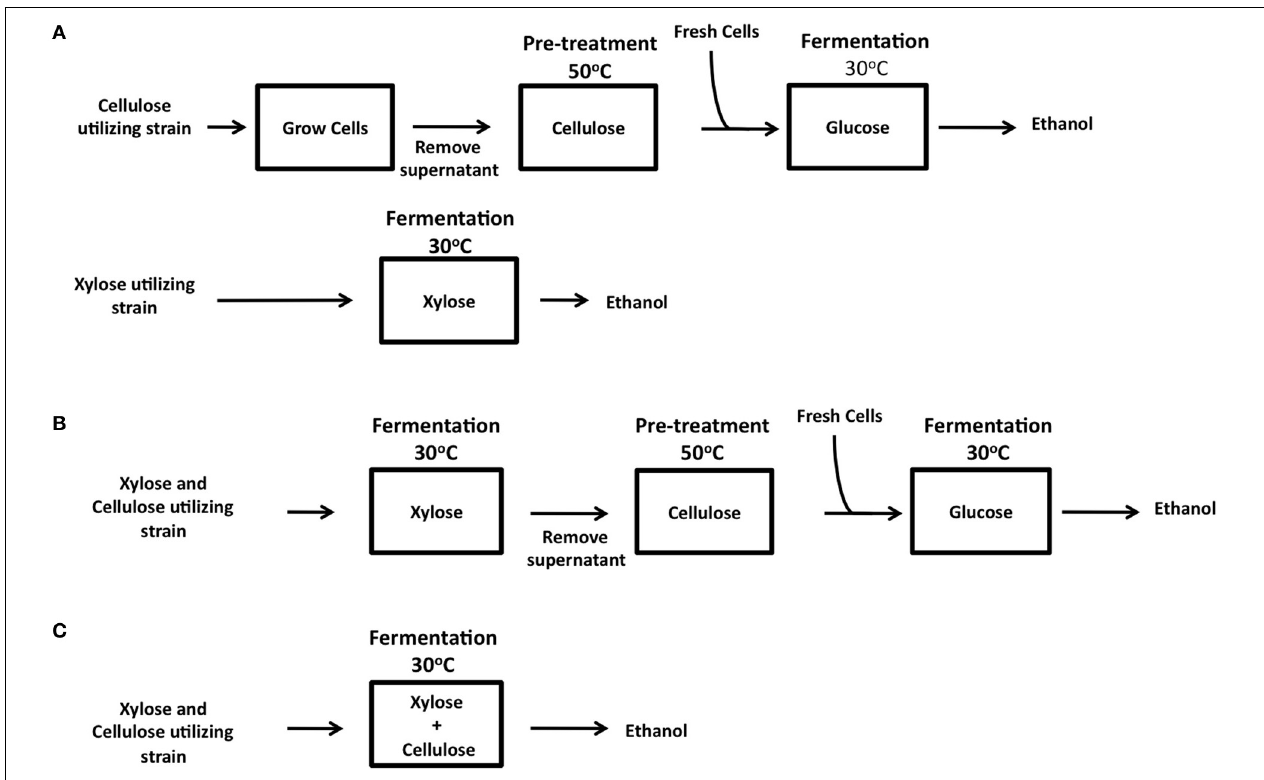
FIGURE 3 | Three possible methods for industrial lignocellulose conversion into bioethanol by SFH in situ . (A) Parallel xylose and cellulose utilization using two different strains for separate xylose and